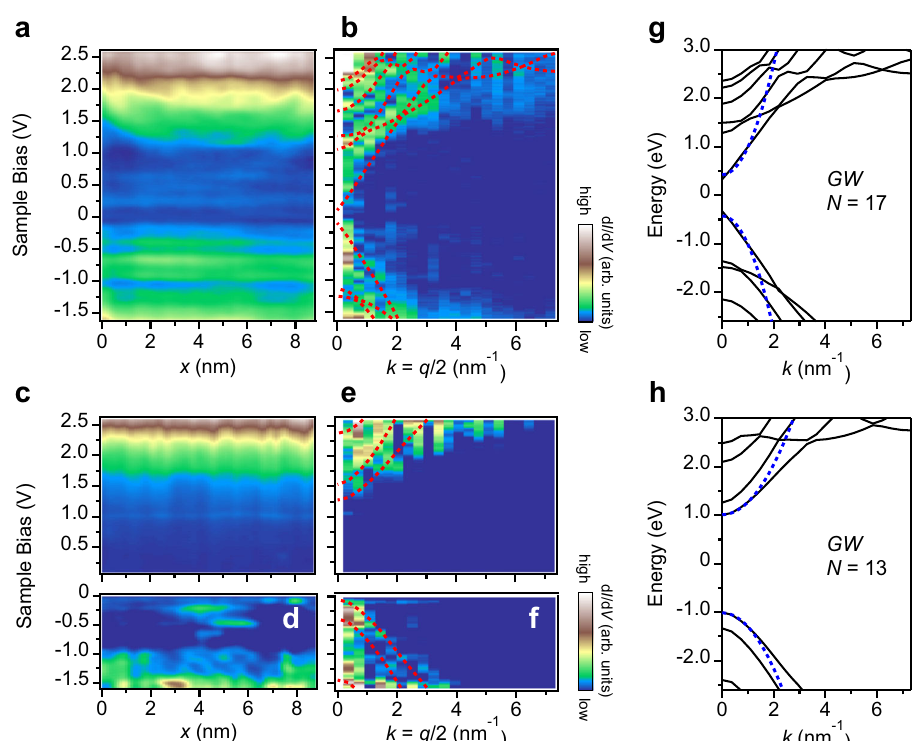
Fig. 6 Electronic band structures of 17- and 13-AGNRs. a Series of d I /d V spectra obtained along one armchair edge of single 17-AGNR with length of 20 a on Au(111) (setpoints: V s = 2.6 V, I t = 0.7 nA, spacing δ x = 0.11). b Fourier-transformed map of a for 0 ≤ k ( = q /2) ≤ π / a . c , d Analogous d I /d V spectral maps of single 13-AGNR with length of 20 a on Au(111) for c unoccupied state (setpoints: V s = 2.6 V, I t = 0.7 nA, spacing δ x = 0.11) and d occupied state (setpoints: V s = − 1.6 V, I t = 0.2 nA, spacing δ x = 0.11). e , f Fourier-transformed maps of c , d . g , h GW quasiparticle band structures (black curves) of freestanding g 17- and h 13-AGNRs, aligned at center of gap (0 eV). Blue dotted curves show parabolic fi ts in rage of 0 ≤ k ≤ 1 nm − 1 to obtain band effective masses. In Fourier-transformed maps of b and e , f , red dotted curves indicate rigid-shifted quasiparticle bands of g and h to compare them with experimental band dispersions. All STS data were obtained at 5